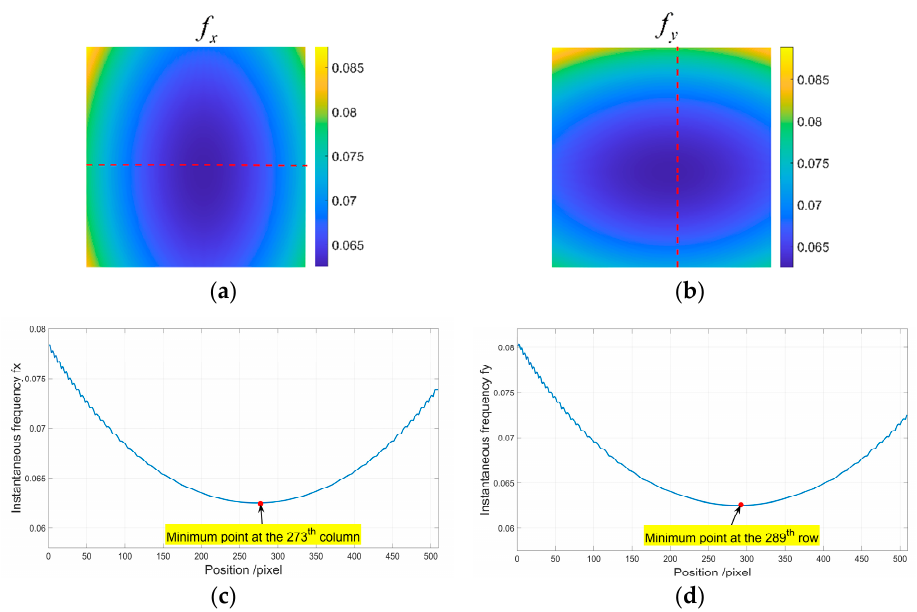
f , where the red dotted lines are y